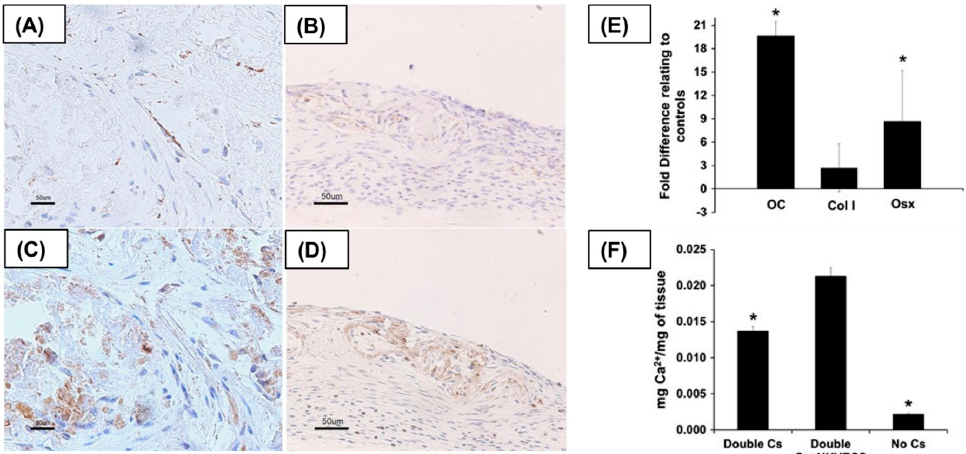
Figure 3. Enhancement of bone-forming ability by co-cultured rat bone marrow stromal cells (rBMSCs) and human umbilical vein endothelial cell (HUVEC)-derived cell sheets (CSs) generated by PNIPAAm-grafted TCPS. Deposition of bone minerals within host tissues after the co-cultured CS implantation. ( A , C ): Co-cultured CS. ( B , D ): Monoculture of rBMSC CSs. Immunostaining of SRY ( A , B ) and osterix ( C , D ). The increase in osteogenic matrix in the dorsal flap in mice after implantation of co-cultured CS. ( E , F ) Reproduced with permission from